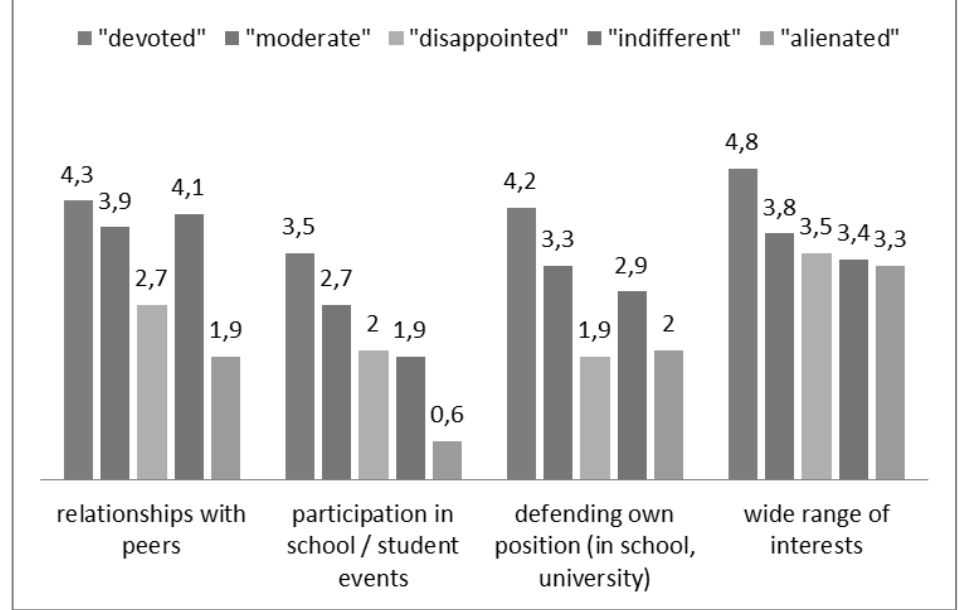
Indicators of interpersonal relationship and subjectness activity of citizens with various types of civic identity Source: Own